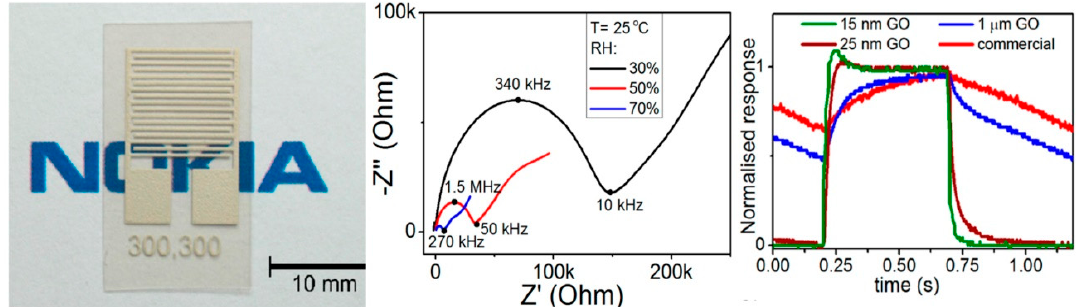
Figure 6. ( Left panel ) photograph of the sprayed GO on Ag electrodes. Only the Ag electrodes are visible, due to the transparency of the deposited ultrathin GO film; ( Central panel ) Nyquist plots of the GO flakes recorded at different RH values; ( Right panel ) response of three GO sensors with different heights to wet air, compared with an ultrafast commercial sensor (adapted with permission from ref. [69]. Copyright 2013, American Chemical Society, Washington, DC, USA).